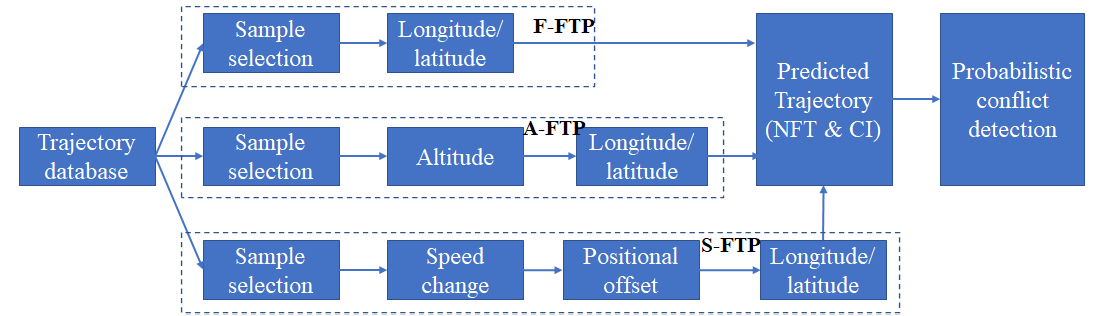
Figure 4. The paradigm of the proposed approach for the different flight operations.